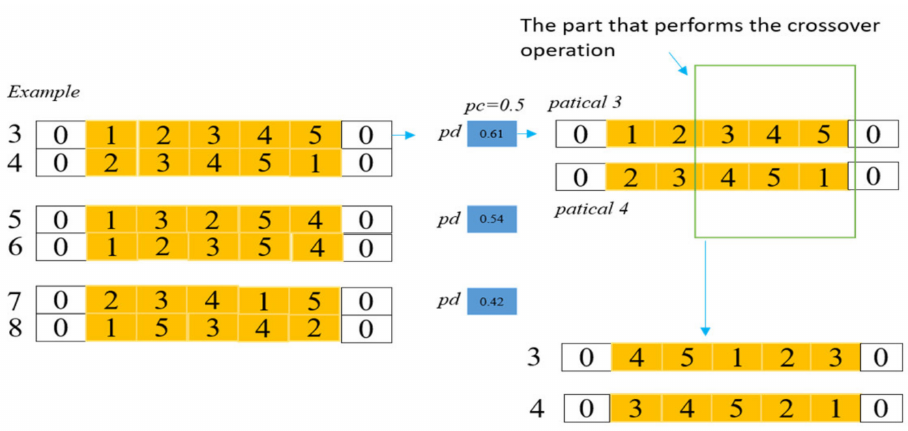
Figure 5. The mechanism of the genetic operators, 0 represents the depot, other numbers denote customers, and blue marks denote different